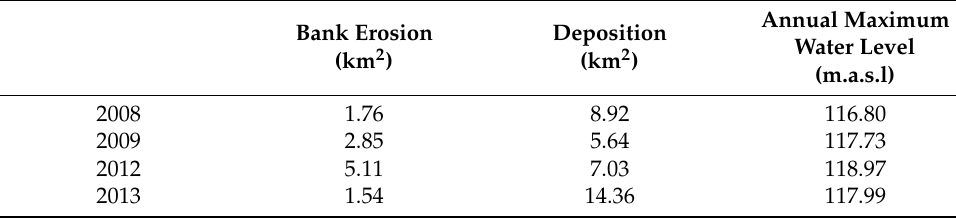
Table 4. Results distribution for bank erosion and deposition of the four-year analysis.